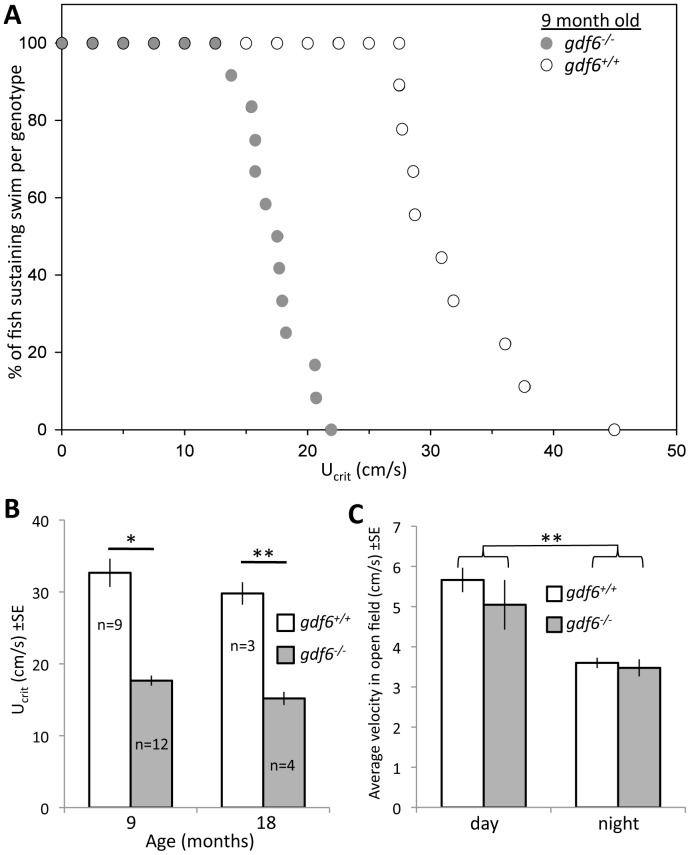
Zebrafish harboring homozygous mutations in gdf6 exhibit decreased endurance.
A.
gdf6−/− fish have a lower endurance compared to gdf6+/+ siblings as measured by increasing water velocity in a swim channel to determine the U
crit i.e. ‘critical swimming speed’ which is taken to be the highest speed that a fish can swim at for a period of several minutes before exhaustion. Each fish tested at 9 months is plotted. B. The same data in panel A (9 month) plotted along with 18 month old siblings. gdf6−/− fish have approximately 50% lower endurance compared to gdf6+/+ siblings at each age (*p = 0.005, **p<0.01). Endurance trends towards being decreased in older fish of each genotype, but this difference is not significant. C. Open field tests of average swim velocity during 10 minutes of each hour through a circadian cycle, in tanks replicating lifetime husbandry conditions, show a lower mean movement at night (in either genotype, **p<0.01) but no difference between genotypes in any measure during day (p = 0.247) or night (p = 0.814).